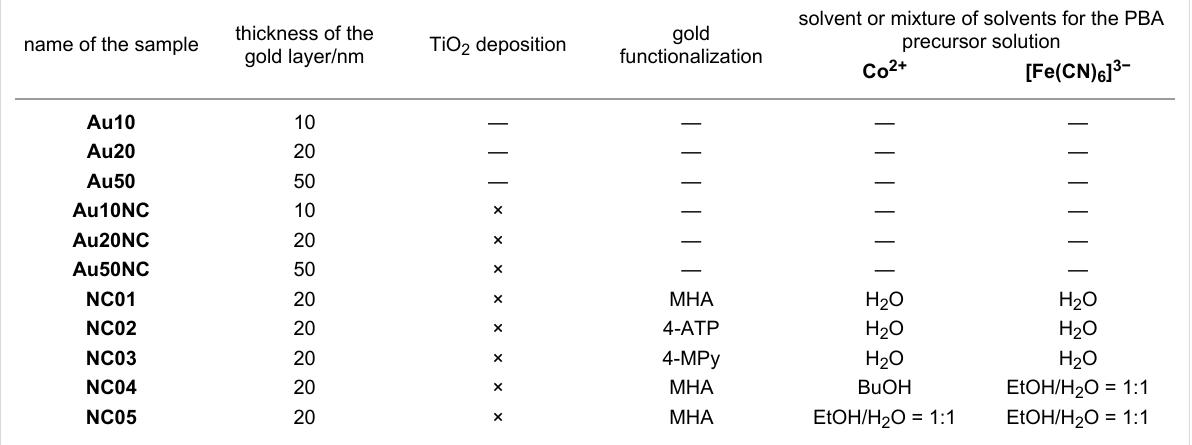
Table 1: Conditions used for the preparation of the different samples.